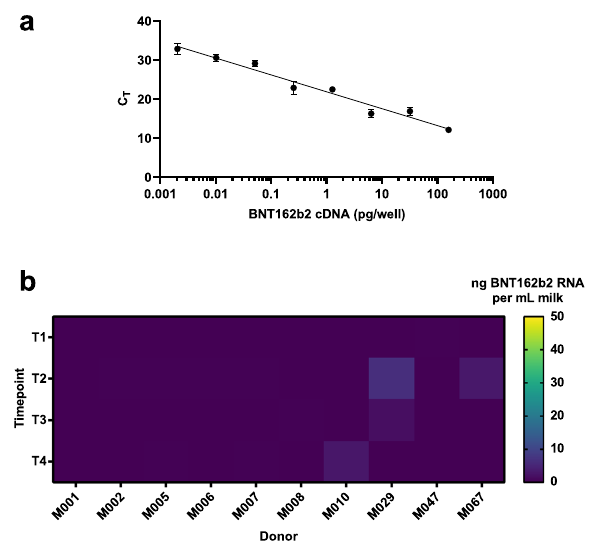
Fig. 4 Minimal transfer of BNT162b2 mRNA into human milk. a Standard curve of cDNA reverse-transcribed from vaccine derived BNT162b2-spiked human milk was made and used as a positive control. n ≥ 6 technical replicates; means are shown with error bars indicating the standard error of measurement (SEM). b Heat map of calculated median BNT162b2 mRNA concentrations in vaccinated women ( n = 10) at four time points as indicated. C T cycle threshold, pg a picogram, ng b nanogram, mL c milliliter, T1 pre-vaccination, T2